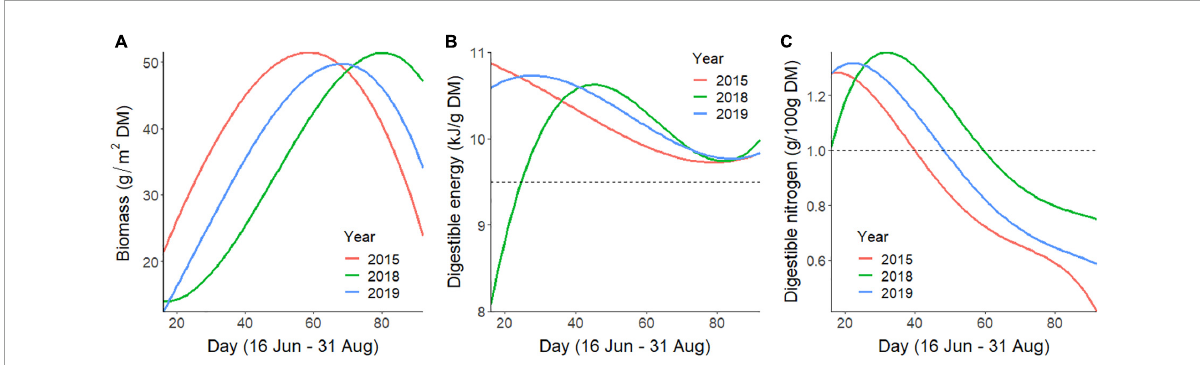
FIGURE2 Predicted temporal trends of daily average values of forage (A) biomass, (B) digestible energy, and (C) digestible nitrogen at caribou locations across the summer (16 June–31 August; days 16–92) for the Central Arctic Caribou Herd, Alaska. Average forage values were smoothed and are depicted for 2015, 2018, and 2019, which represent years with early, late, and moderate summer phenology, respectively. The horizontal dotted reference lines for digestible energy and nitrogen indicate thresholds identified for non-lactating, conspecific, female reindeer to gain mass during summer.